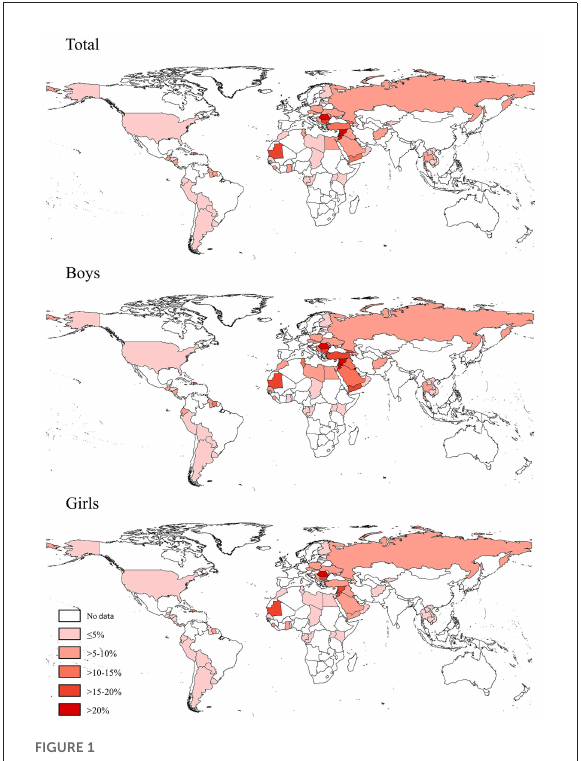
FIGURE1 Prevalence of waterpipe smoking (on ≥ 1 day during the past 30 days) among adolescents aged 12–16 years in 73 countries/territories in